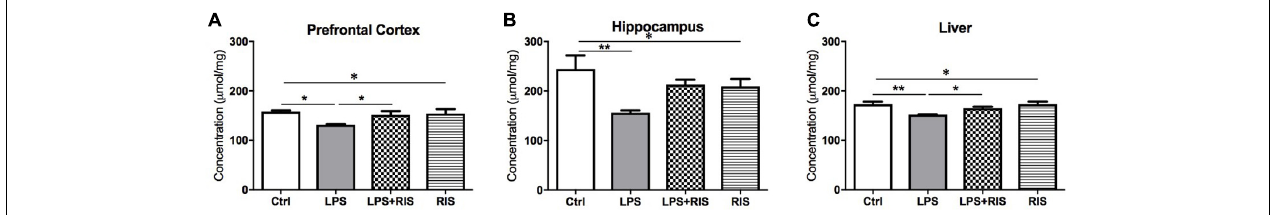
FIGURE 6 | Effect of various treatments on the level of glutathione (GSH). Groups are Ctrl (control), LPS (lipopolysaccharide), LPS + RIS (lipopolysaccharide + risperidone), and RIS (risperidone). GSH was measured from the prefrontal cortex (A) , hippocampus (B) , and liver (C) tissues. Values are represented as mean ± SEM. Post hoc multiple comparison test namely, “Newman–Keuls” test was used to compare between groups. n = 6 per group. ∗ p < 0.05, ∗∗ p < 0.01, ∗∗∗ p <